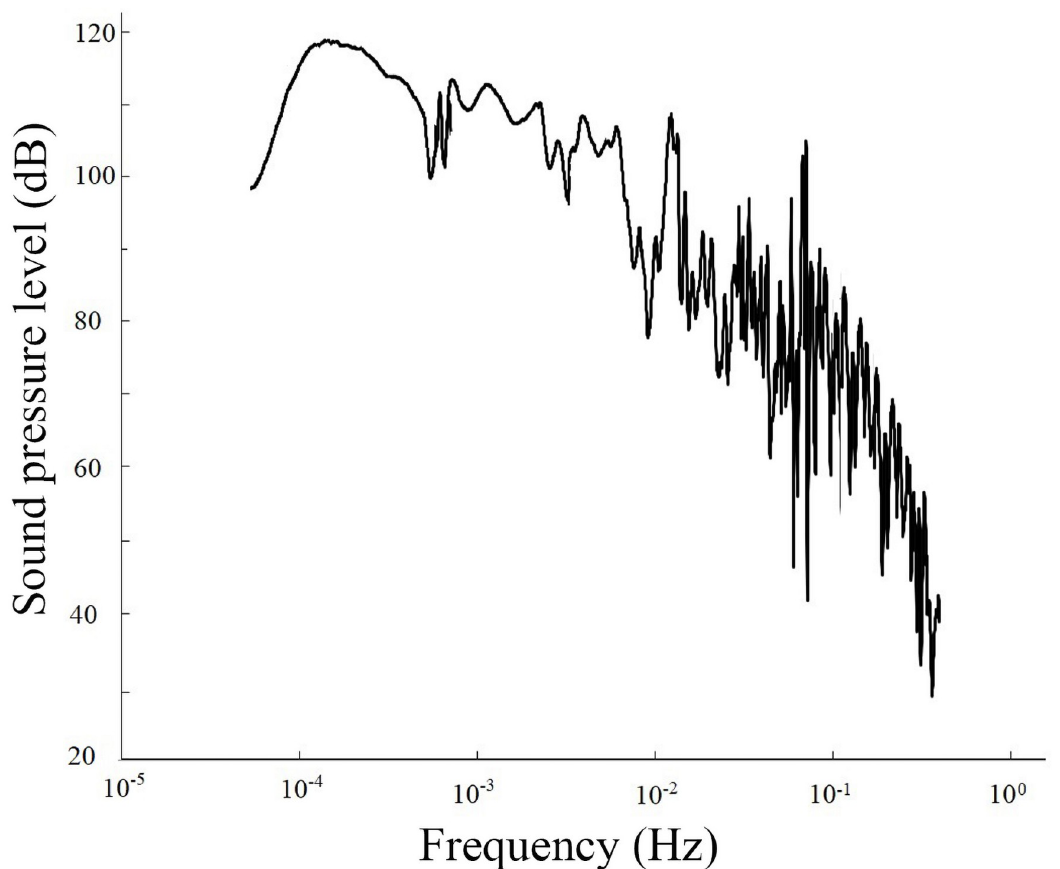
Fig 6. Frequency of anomalous infrasound signals on March 29, 2002.